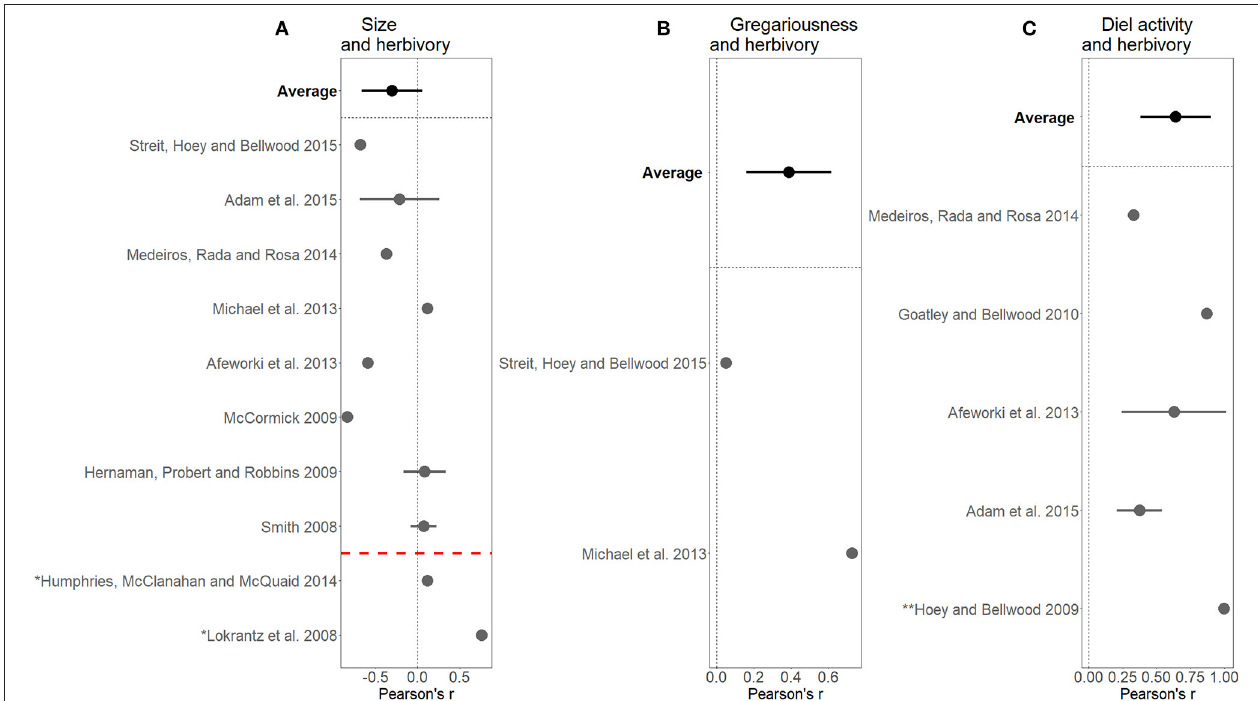
FIGURE 6 | Pearson’s r correlation coefficients with 95% confidence intervals for papers linking (A) size and herbivory, (B) gregariousness and herbivory, (C) diel activity and herbivory. Averages of Pearson scores for all the papers are highlighted in bold for each graph. The red dotted line in (A) separates out two papers excluded from average as they measured herbivory in a form other than bite rate. * Bite impact rather than rate (e.g., amount of algae removed). ** Bite rate standardized by